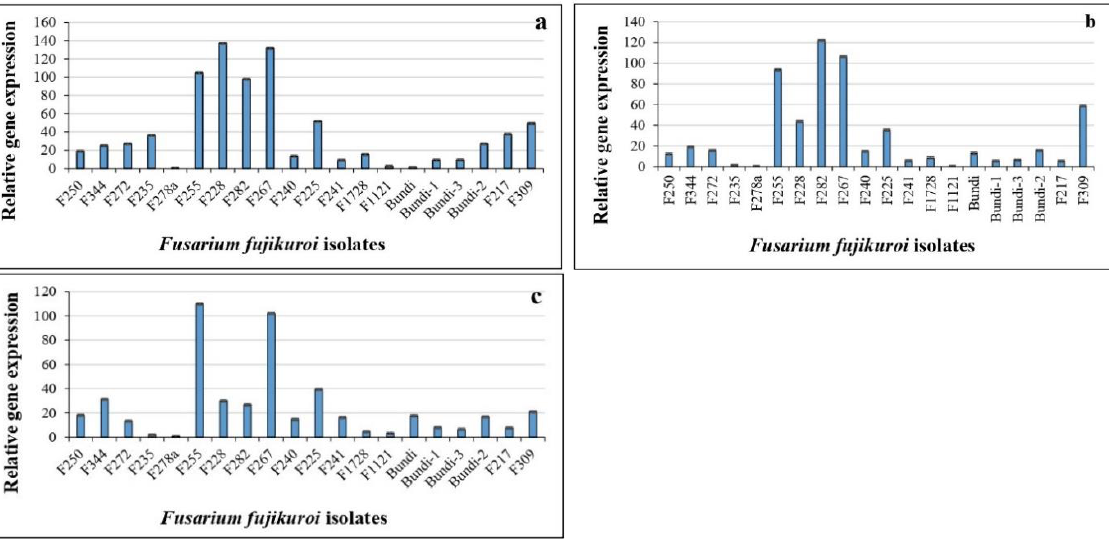
Figure 6. Relative expression of virulence-related genes in selected Fusarium fujikuroi pathotypes. ( a ) Acetylxylan ( FFAC ), ( b ) exoploygalacturanase ( FFEX ), and ( c ) pisatin demythalase ( FFPD ). The relative gene expression data were used for grouping of Fusarium fujikuroi isolates and pathotype correlation. Error bars represent standard error.